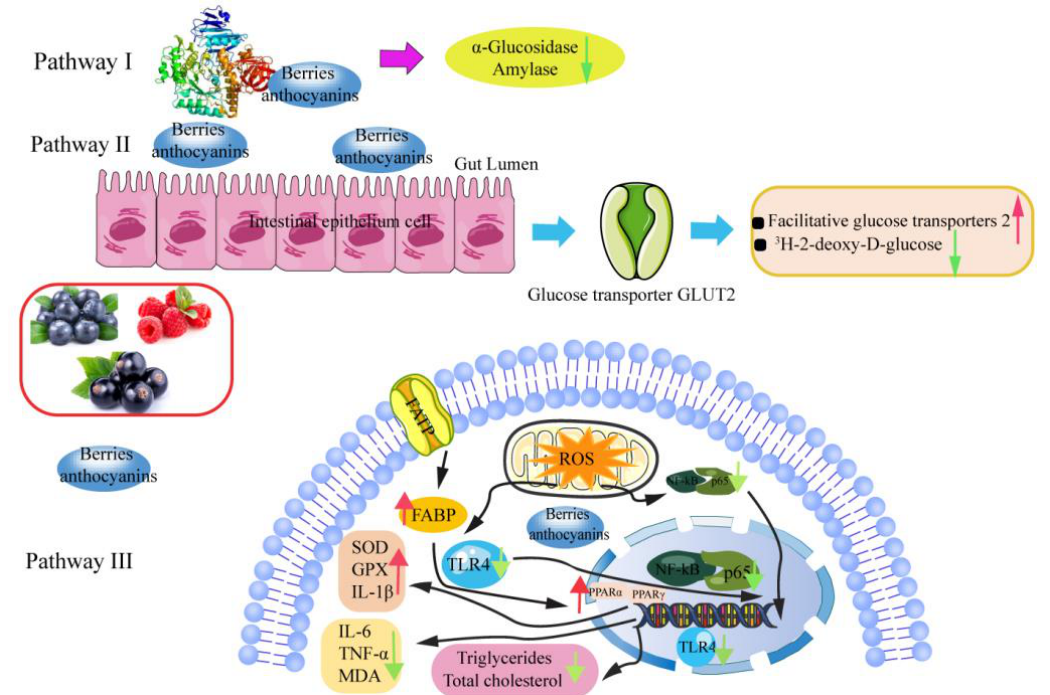
Figure 6. Hypoglycemic mechanisms of berry anthocyanins in enzyme activity, cell and animal models. Note: ↑ shows up-regulation; ↓ represents down-regulation